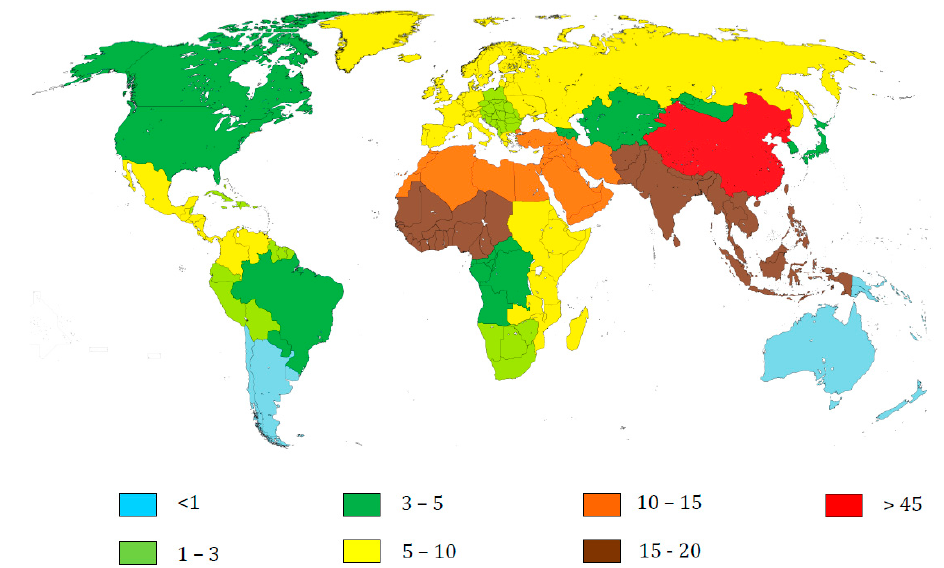
Figure 1. Worldwide estimated people with anti-HCV antibodies in 2016 (in millions) in 21 GBD regions. Data obtained from References [1,3].